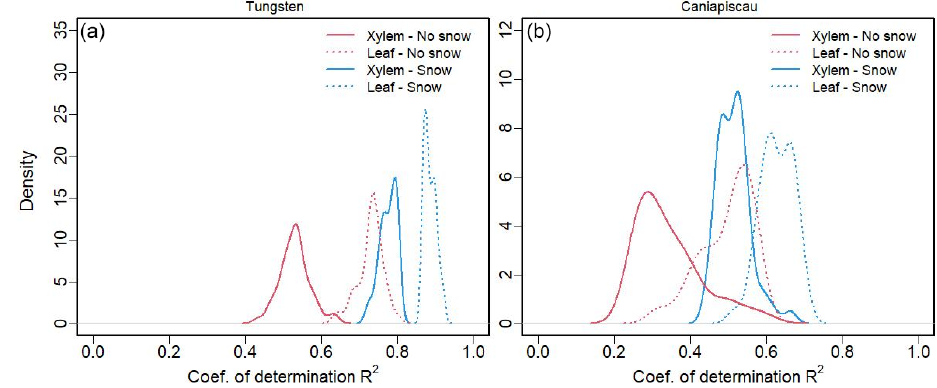
Figure 9. Density distribution of the coefficients of determination ( R 2 ) between the reference simulations and the water source (xylem) experiments (solid line, δ 18 O V and h air set constant), and the leaf water enrichment experiments (dashed line, δ 18 O XW set constant) for the model without snow (red) and with snow (blue). Data are shown for (a) Tungsten and (b)